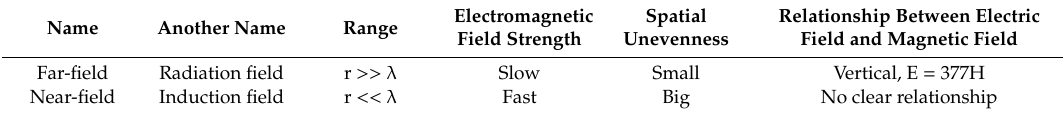
Table 1. The difference between far-field and near-field.